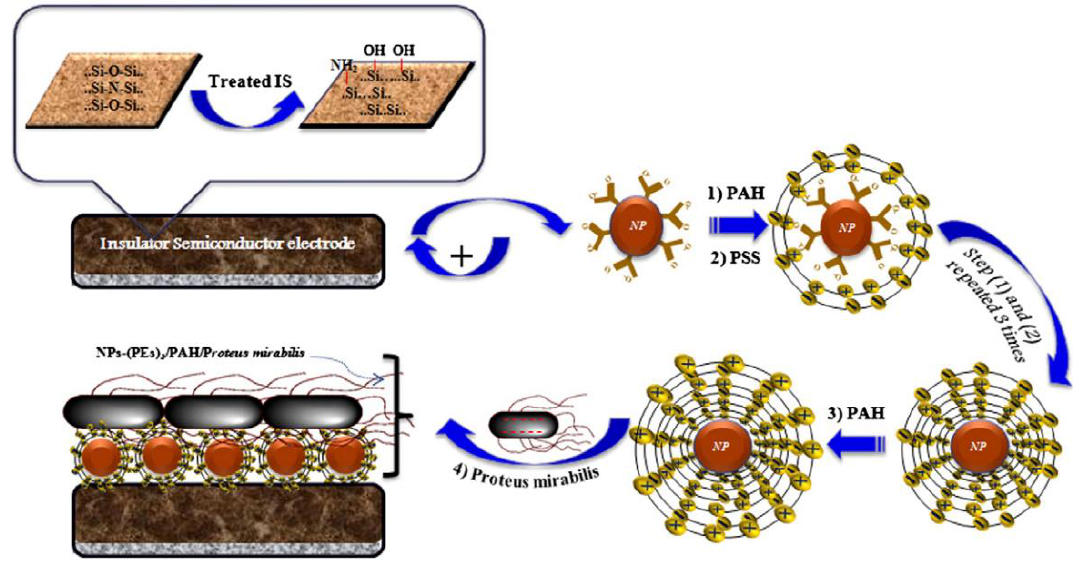
Figure 9. Schematic view of a capacitive urea biosensor based on Fe 3 O 4 and polyelectrolytes. Reprinted from [88] with permission from the Elsevier.